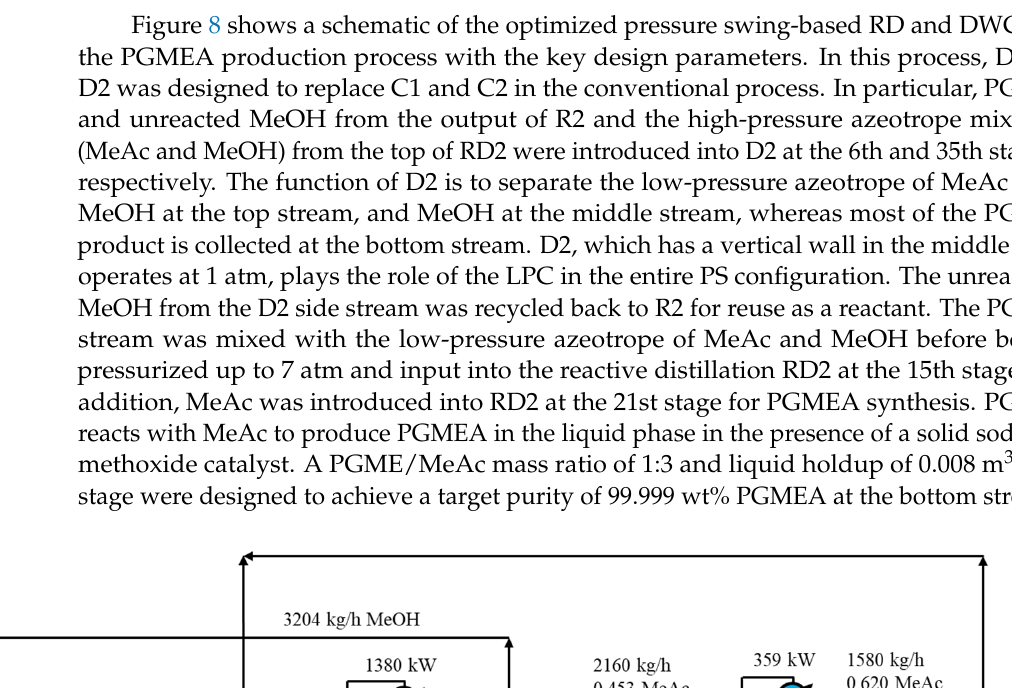
Figure 7. Optimization of DWC structure. ( a ) DWC is noted as D2 column; ( b ) fully-thermally coupled column equivalent to DWC in Aspen Plus Simulation. Column D2 has two columns B1 (prefractionator) and B2 (main column).